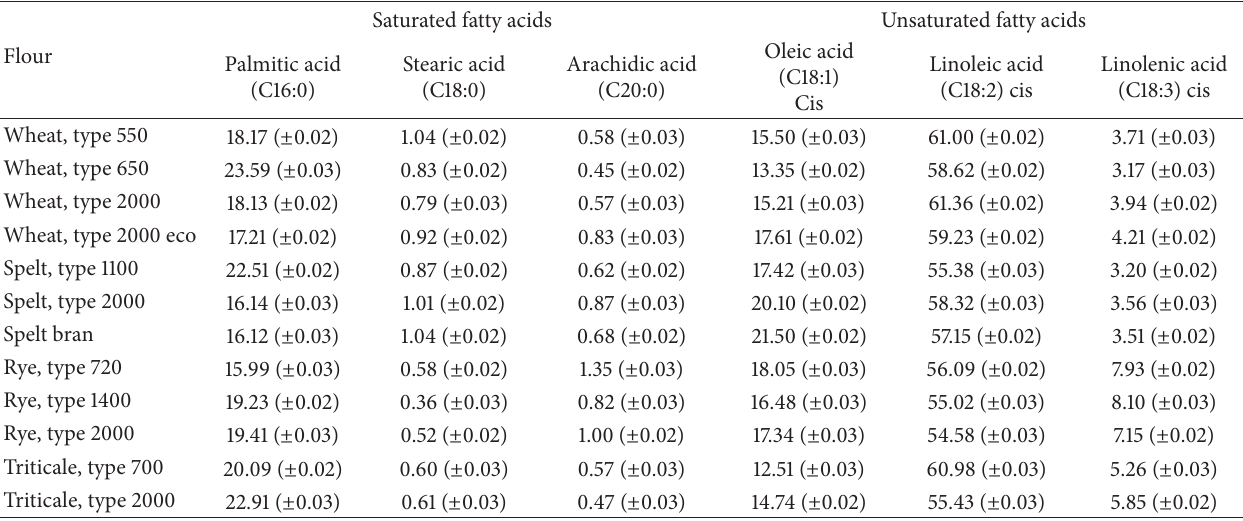
Table 3: Fatty acid composition (%) of crude fat extracted from the studied flours ( 𝑛 = 2 ).